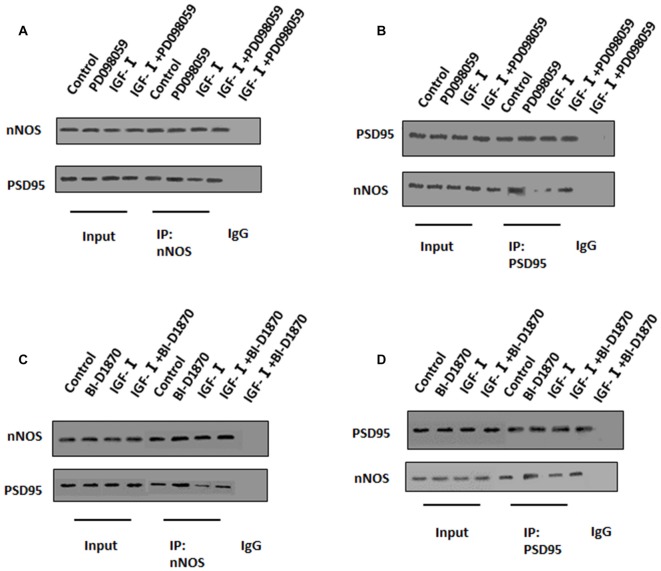
IGF-I stimulates the disruption of RSK–nNOS interaction via ERK1/2/RSK signaling. (A) Immunoprecipitation of lysates of PHNs with or without IGF-I treatment in the absence or presence of PD098059 using control IgG or anti-nNOS antibodies. Complexes were immunoblotted with anti-nNOS/PSD95 antibodies. (B) Immunoprecipitation of lysates of PHNs with or without IGF-I treatment in the absence or presence of PD098059 using control IgG or anti-PSD95 antibodies. Complexes were immunoblotted with anti-PSD95/nNOS antibodies. (C) Immunoprecipitation of lysates of PHNs with or without IGF-I treatment in the absence or presence of BI-D1870 using control IgG or anti-nNOS antibodies. Complexes were immunoblotted with anti-nNOS/PSD95 antibodies. (D) Immunoprecipitation of lysates of PHNs with or without IGF-I treatment in the absence or presence of BI-D1870 using control IgG or anti-PSD95 antibodies. Complexes were immunoblotted with anti-PSD95/nNOS antibodies.